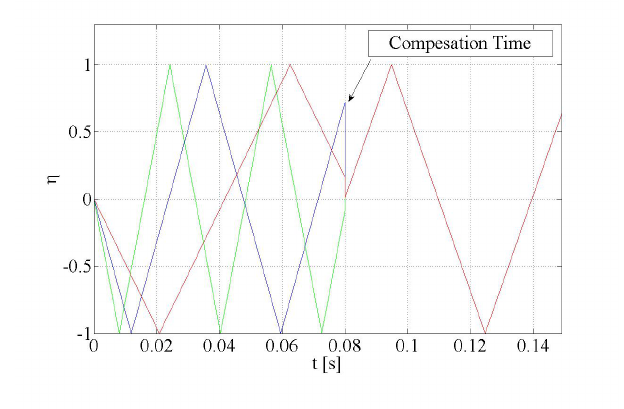
Figure 14. The PWM modulation waveform signals of the three nodes, with tdel = 10 − 4 s